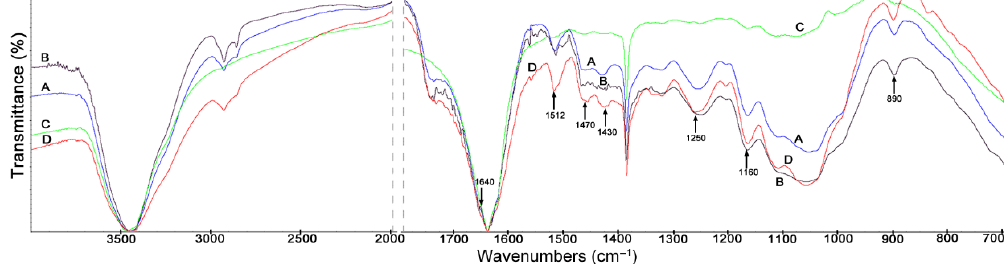
Figure 5. FTIR spectra of maize stover fractions: ( A ) cobs, ( B ) husks, ( C ) leaves, ( D ) stalks.